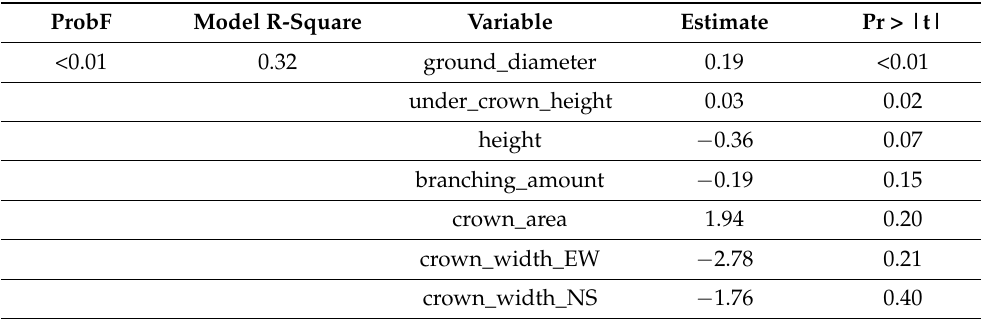
Table 3. PCA (primary component analysis) linear multivariate model predicting green nut yield per tree with morphological